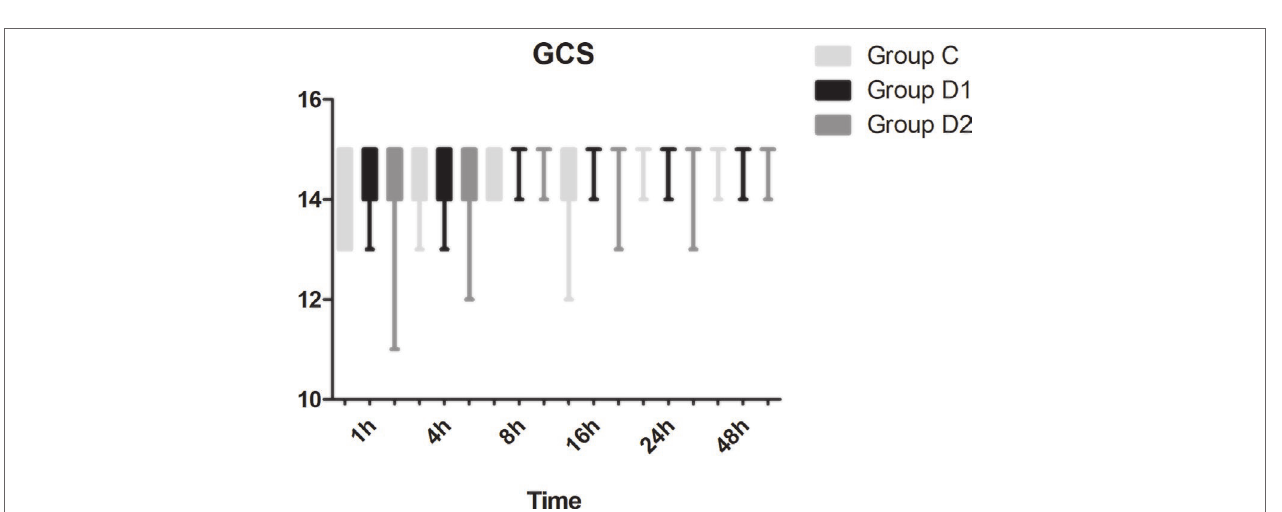
FIGURE 7 | Comparison of Bruggemann Comfort Scale (BCS) scores among the three groups. BCS: 0, persistent pain; 1, severe pain while deep breathing or coughing; 2, mild pain while deep breathing or coughing; 3, painless while deep breathing; 4, painless while coughing. * P < 0.05 vs. group C.